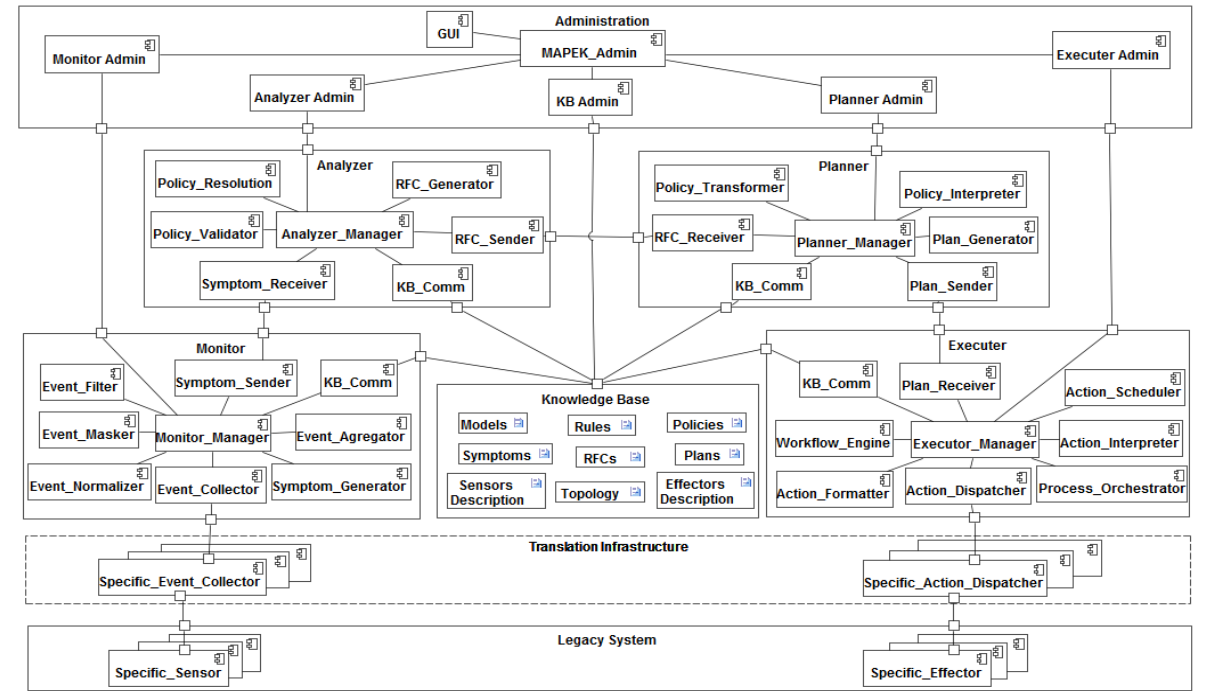
Figure 4. The component model of the Autonomic M2M Manager